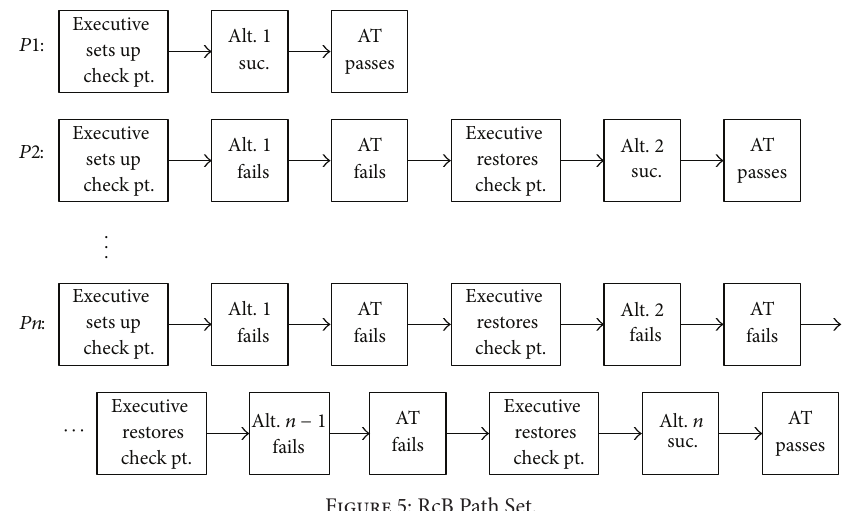
Figure 5: RcB Path